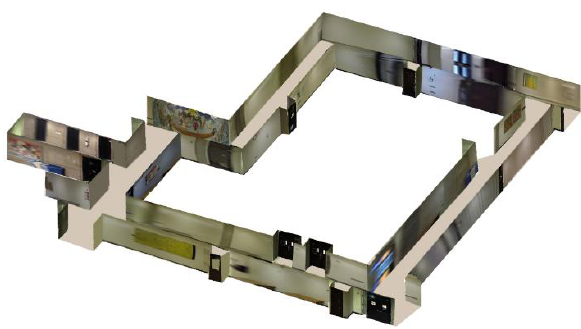
Figure 7. The generated photo-textured indoor map by aligning individual reconstructed image-based 3D